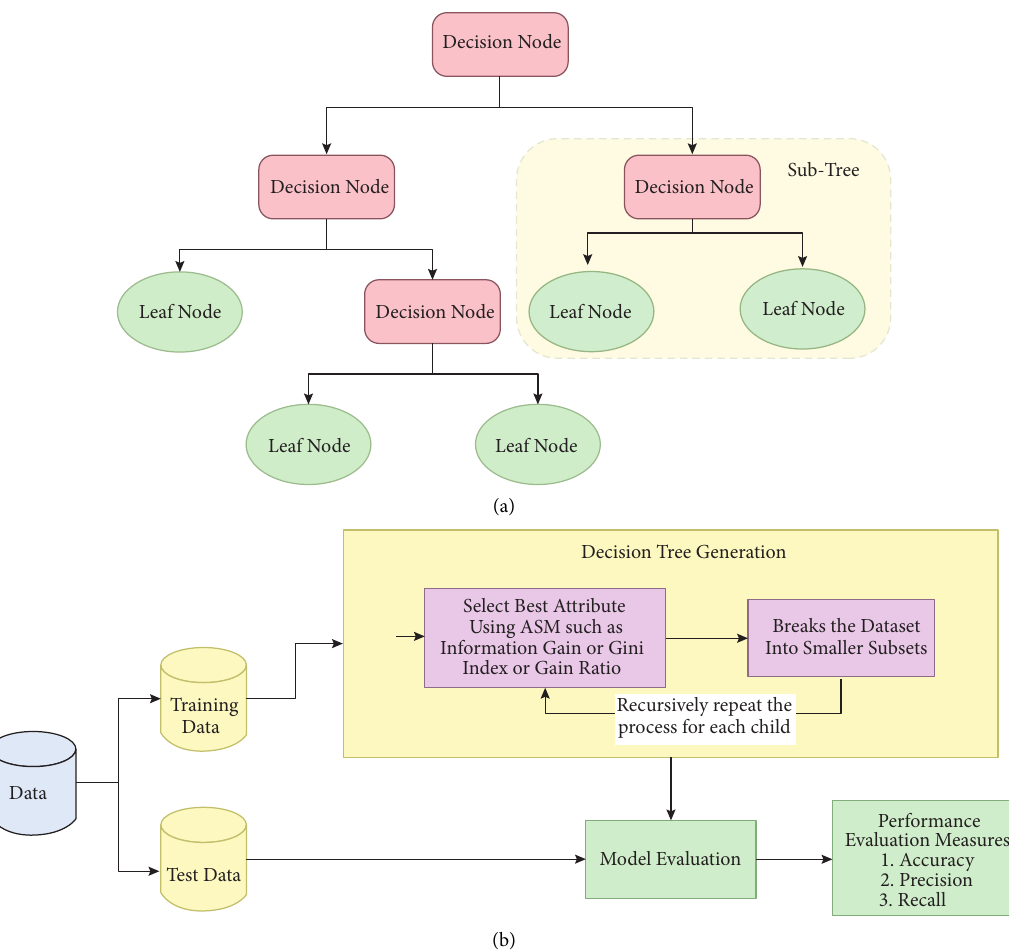
Figure 10: Decision tree and decision tree generation: https://www.datacamp.com/community/tutorials/decision-tree-classification- python. (a) Decision tree. (b) Decision tree